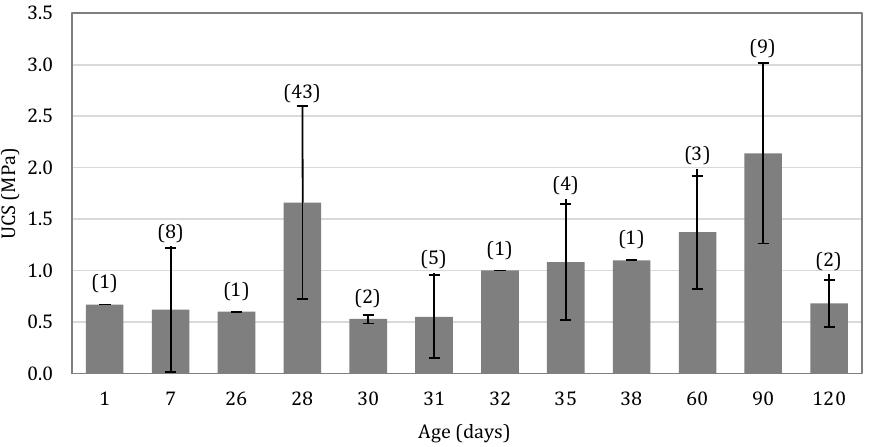
Figure 3. Average value of UCS with respect to the age of the specimen at the time of testing.